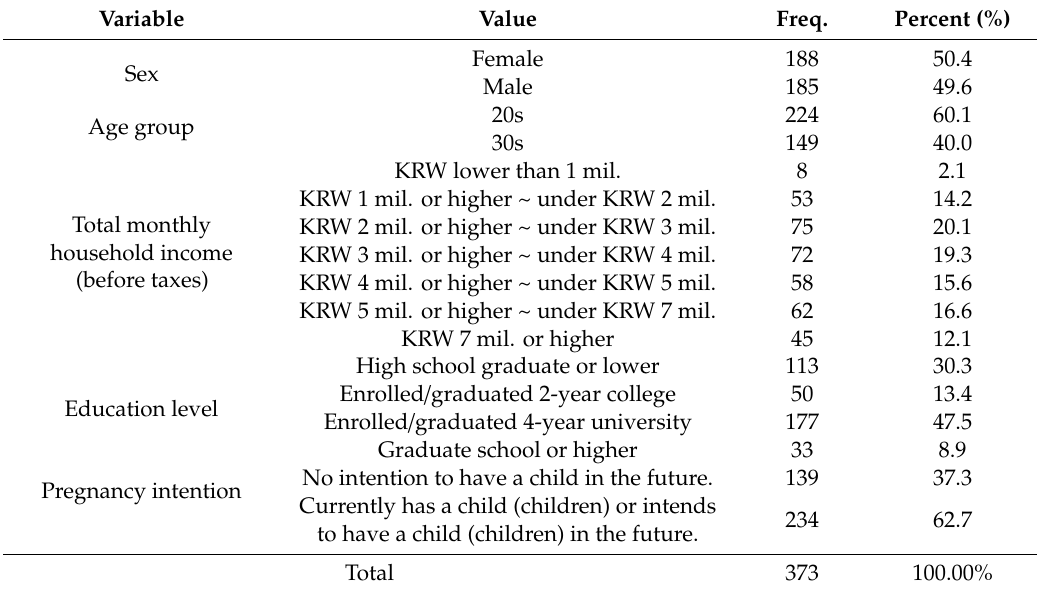
Table 3. Demographic characteristics of